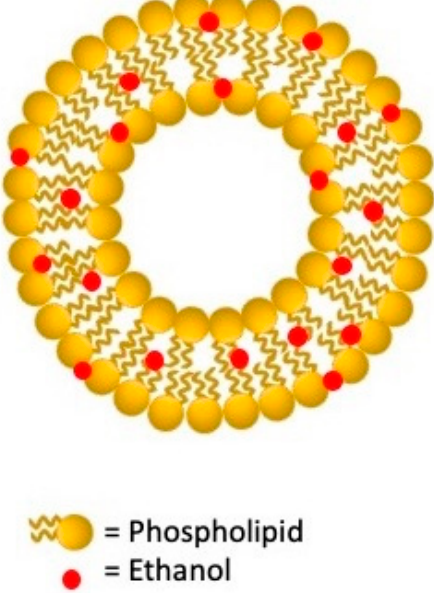
Figure 3. Schematic structure of ethosome lipid vesicular system. Table 3. Ethosomes’ drug delivery applications.